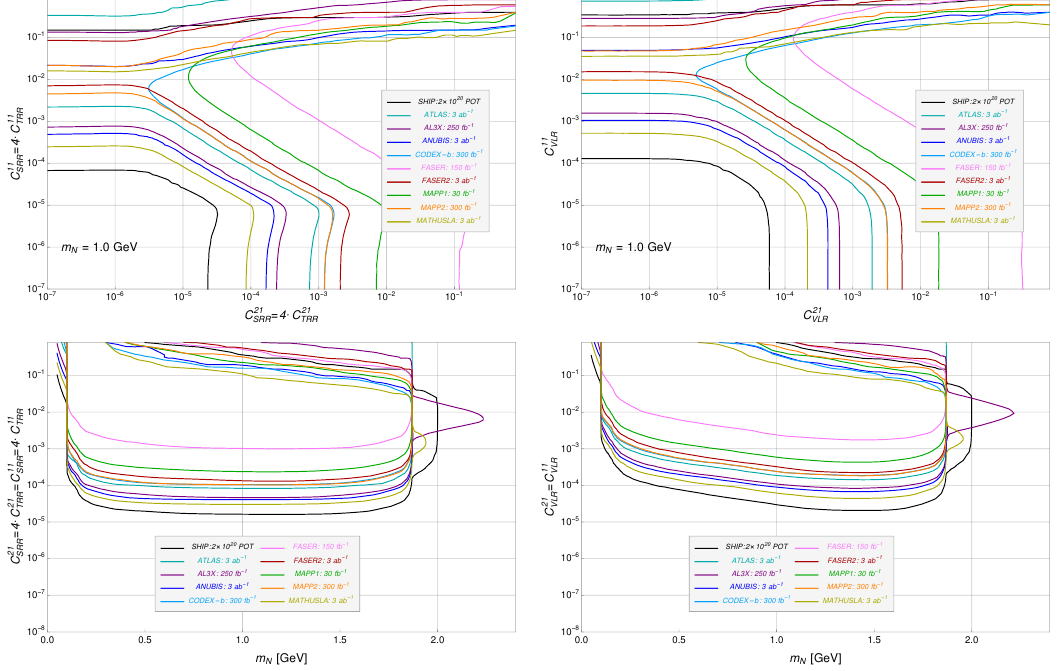
Figure 7 . Results for the sensitivity reach for (cid:13)avor benchmark 1. On the left we have the leptoquark-like case, and on the right the VLR case. For each case the upper (cid:12)gure shows C D vs. C P , where as the lower case is for C P = C D and shows C P vs. m N . The color code for the various experiments is shown in each